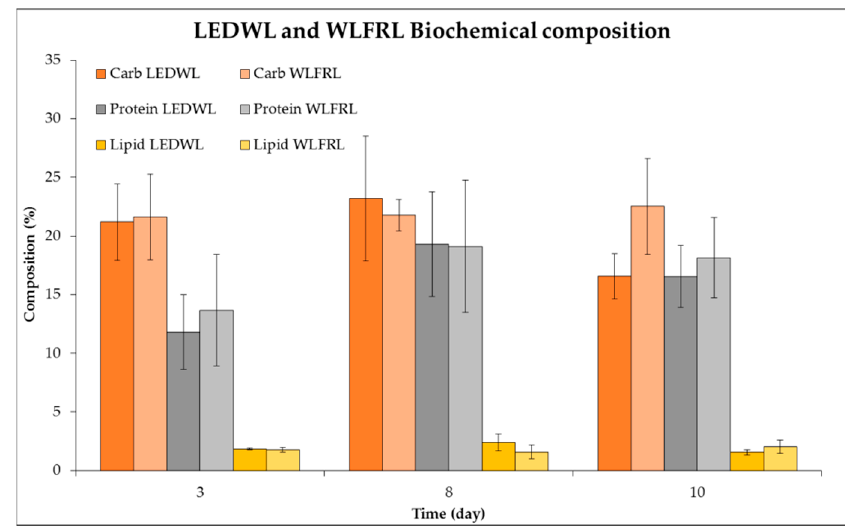
Figure 8. Biochemistry composition (%) of C. fritschii grown under LEDWL and WLFRL conditions.